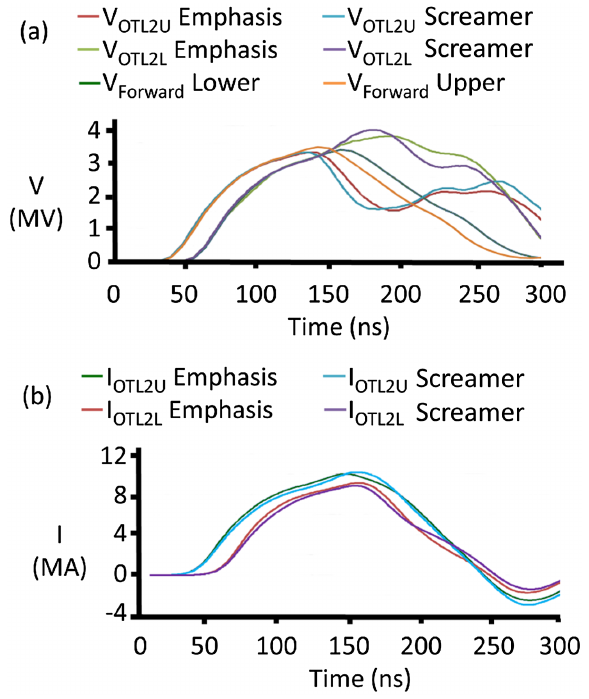
FIG. 10. (a) Voltages and (b) currents at the second output transmission line (OTL2) are shown from Emphasis and Screamer simulations of the CSMITL. The letters U and L, respectively, indicate the upper and lower modules. The upper and lower forward going voltages at the OTL2 positions are also shown in Fig.